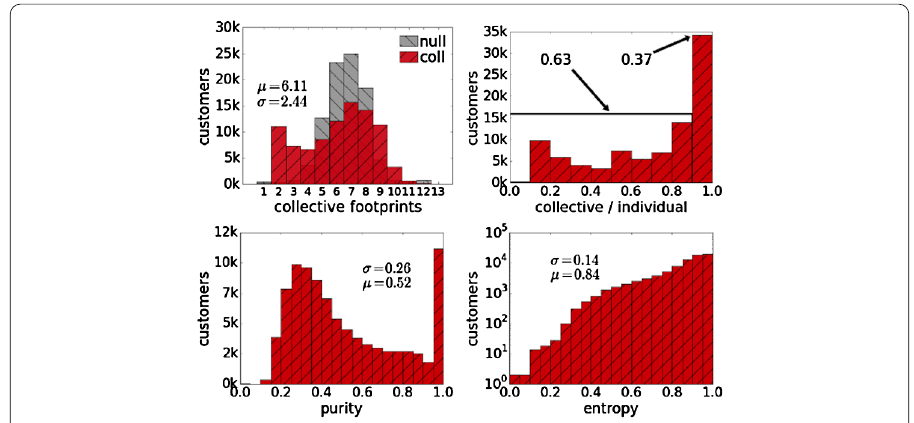
Figure 6 Collective footprints analysis. Distributions of customers per: number of collective footprints and null model (upper right), ratio between number of collective footprints and individual footprints (upper left), purity (lower left), entropy (lower